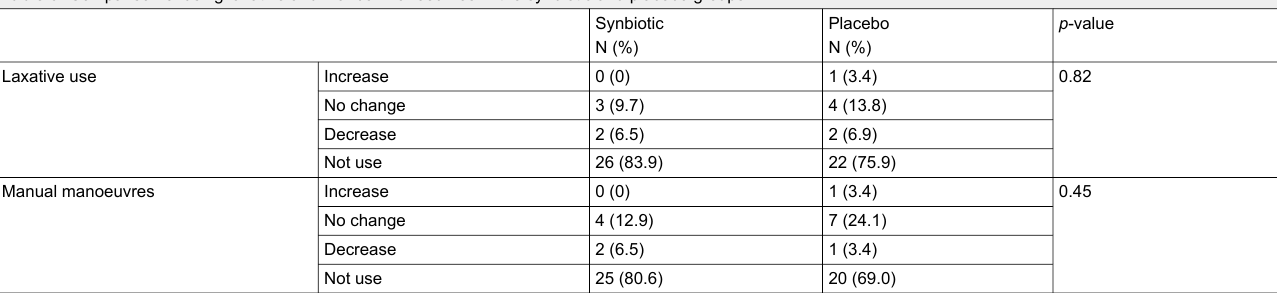
Table 5: Comparison of using laxative and manual manoeuvres in the synbiotic and placebo